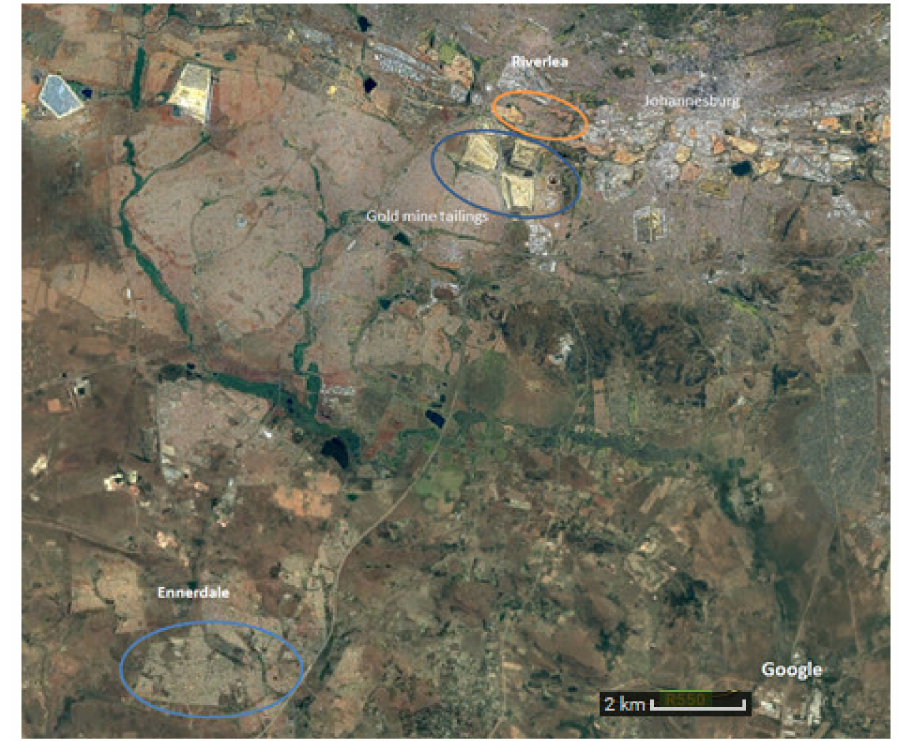
Figure 1. Map of the study area indicating the study sites and gold mine dumps (source: Google Earth v 9.2.65.2, Johannesburg, Gauteng Province, South Africa. 26 ◦ 08’45”S 28 ◦ 16’08”E, Eye altitude 1662 m. Digital Globe 2012. http: // www.earth.google.com (August 20,